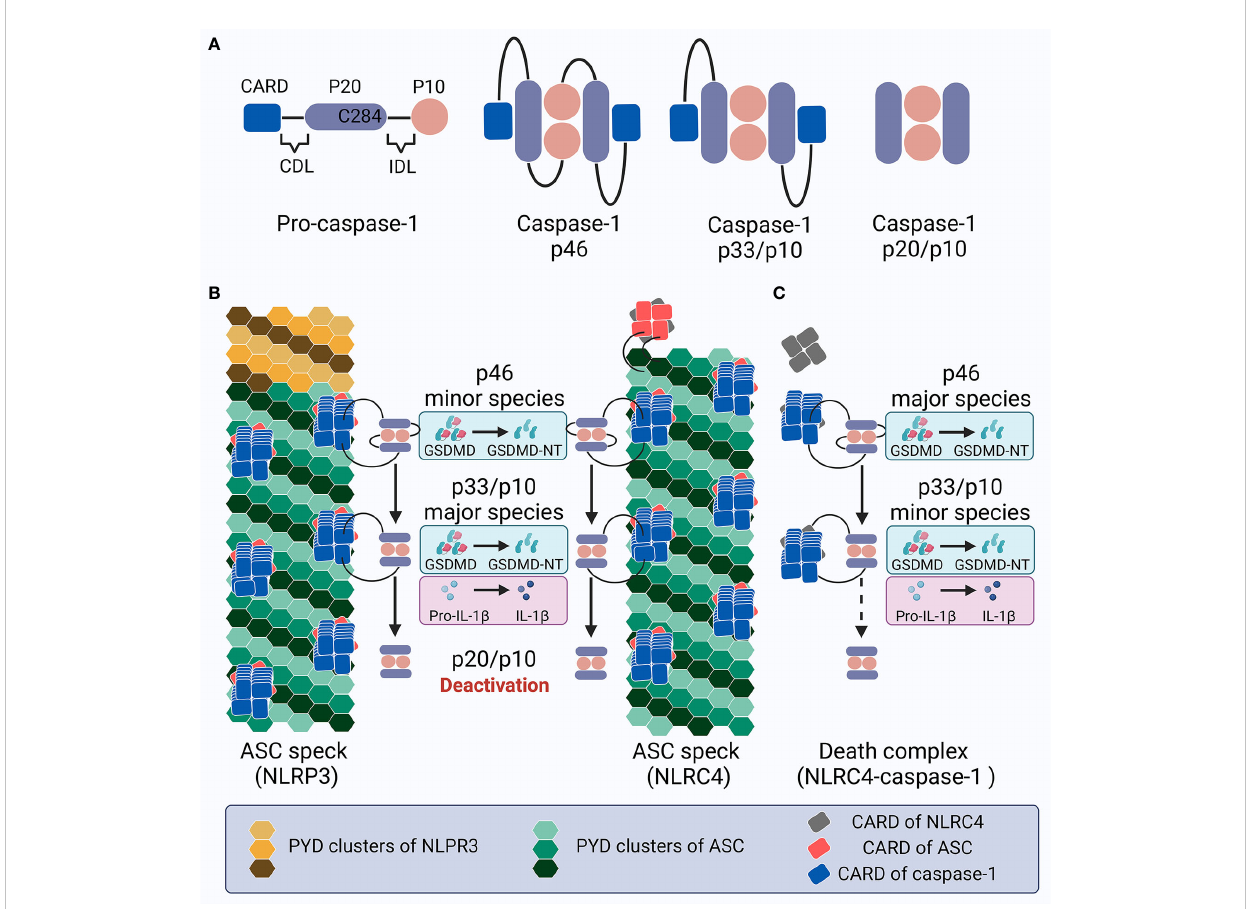
FIGURE 4 Schematic showing caspase-1 activation and deactivation. (A) Structure of pro-caspase-1 and caspase-1 species generated by dimerization and auto-processing during in fl ammasome activation. (B) Upon NLRP3 or NLRC4 in fl ammasome activation in cells expressing ASC, specks recruit pro- caspase-1 molecules, leading to proximity-induced dimerization, generation of p46 species (minor), and later auto-proteolysis; this process fi rst occurs at the IDL to generate p33/p10 species (major), and subsequently at the CDL to create and dislocate the inactive p20/10 species. The p46 species cleaves GSDMD into GSDMD-NT, while p33/p10 species cleaves both GSDMD and IL-1 b . In contrast, the p20/p10 species is incompetent for processing GSDMD and IL-1 b . Within the ASC speck, caspase-1 activation and deactivation is rapidly promoted with a high turnover. (C) Upon NLRC4 in fl ammasome activation in ASC de fi cient cells, the turnover of p46 into p33/p10, and especially p33/p10 into p20/p10 (illustrated with a dotted arrow), slows down; this leads to prolonged caspase-1 activity, with p46 and p33/p10 as the major and minor species, respectively, which may contribute to the pyroptosis-predominant uncoupling without massive IL-1 b release. This in fl ammasome complex is called the death